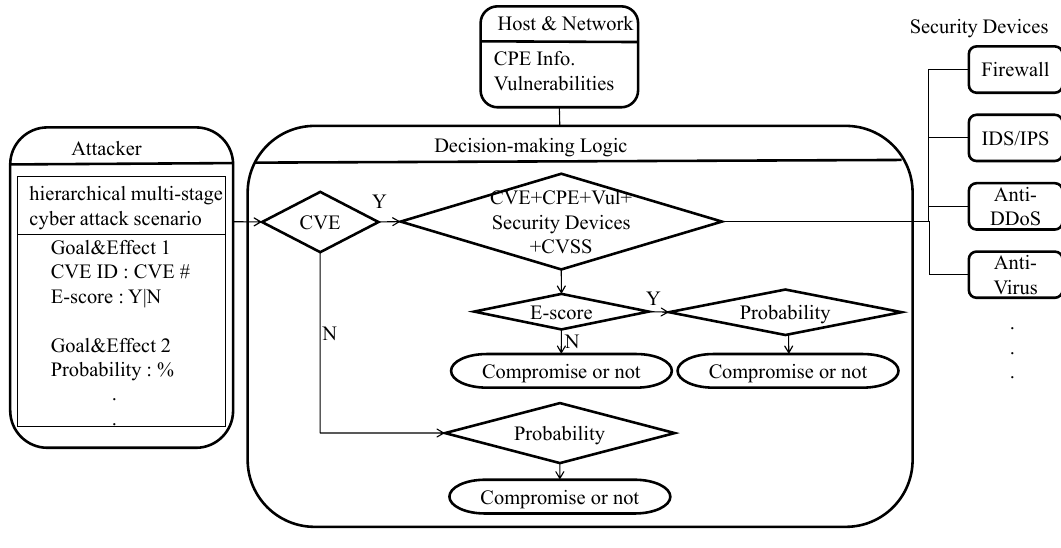
Figure 4. Overview of decision-making logic.